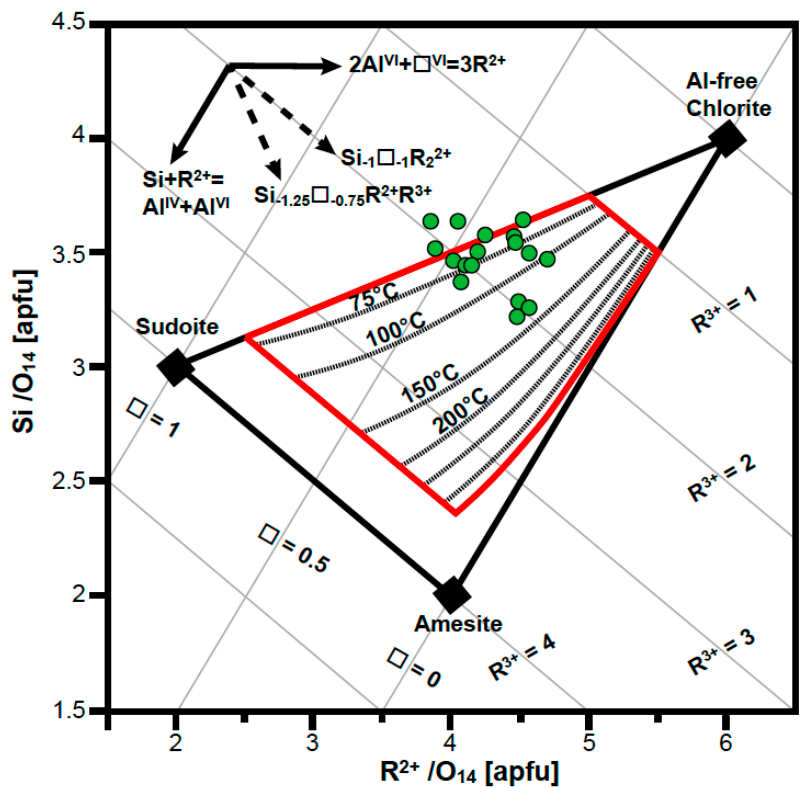
Figure 12. Semi-empirical graphical chlorite geothermometer of Bourdelle and Cathelineau [41], applied on the baileychlore analyses obtained with this study. In the top-left corner, the element substitution vectors are shown.